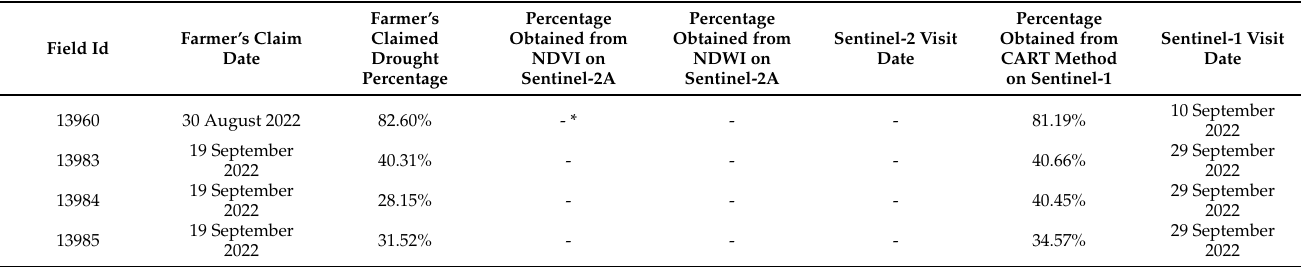
Table 10. Percentage of drought area obtained from farmer’s claims as well as our proposed methods used in satellite